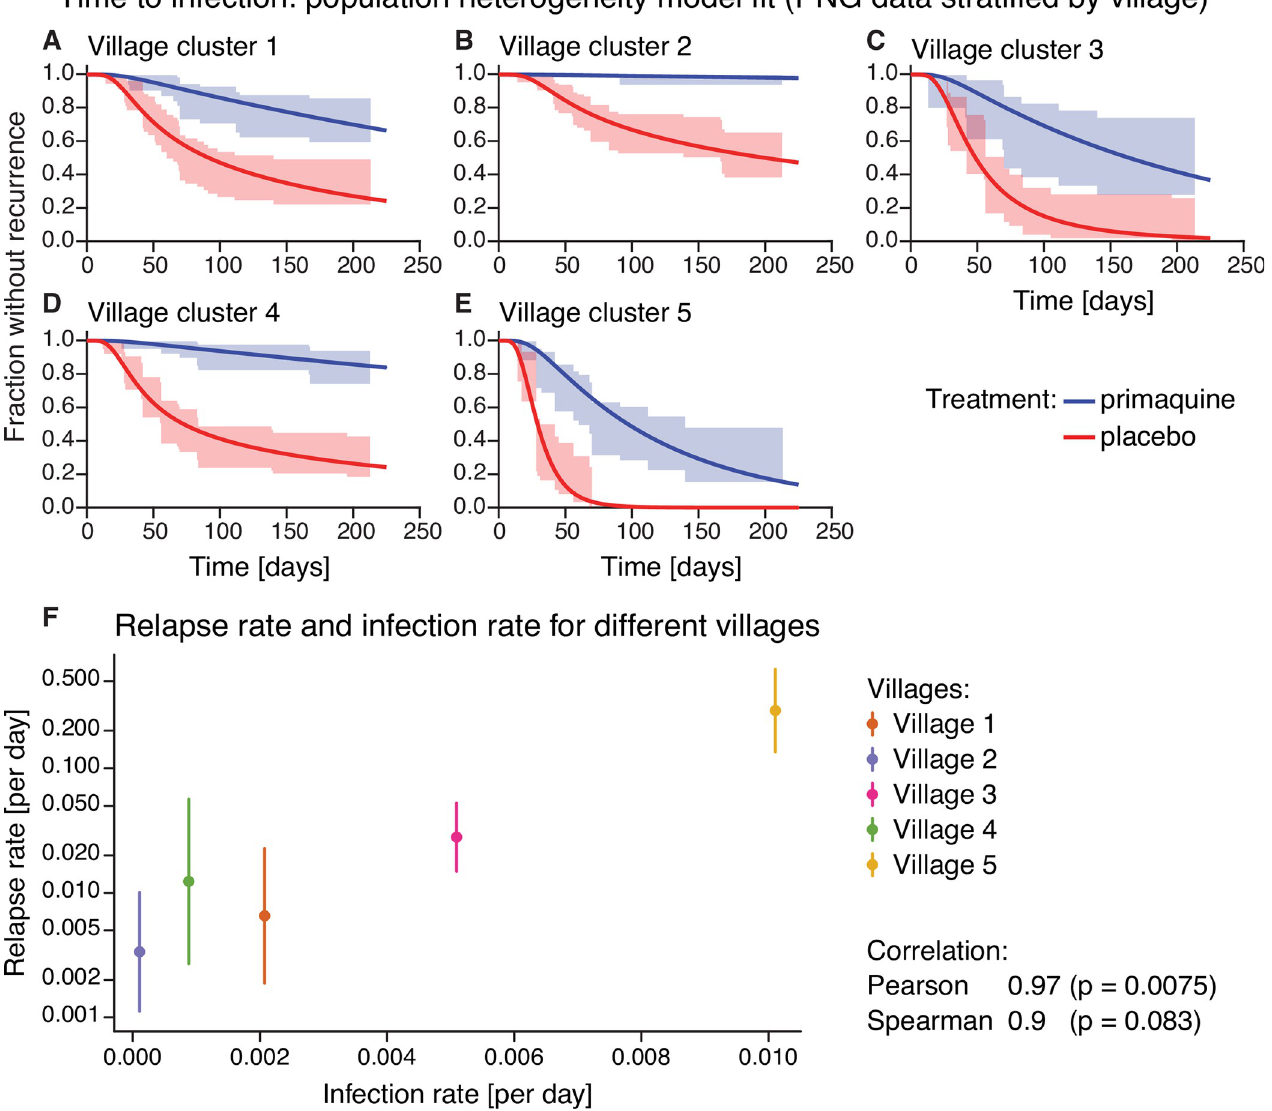
Fig 5. Time to infection population heterogeneity model fit and relapse rate vs infection rate for different villages in the Papua New Guinea data. ( A-E ) Model fit of the population heterogeneity model to the time to infection data from Papua New Guinea stratified by village. All villages were fit simultaneously with the same drug washout time distribution, the rate of new infections and relapses was allowed to vary between villages. The lines indicate the model fit and the shaded area the 95% confidence region from the data. ( F ) Relapse rate and infection rate for different villages. For each village, the median relapse rate (dot) and interquartile range (vertical line) of the relapse rate distribution from the population heterogeneity model fit is plotted against the infection rate. The Pearson and Spearman correlation between the log-transformed median relapse rate and the infection rate are 0.97 and 0.9, respectively, with p-values of 0.0075 and 0.083, respectively. For model fits to the Papua New Guinea data by village using the other models see Figs C and D in S1